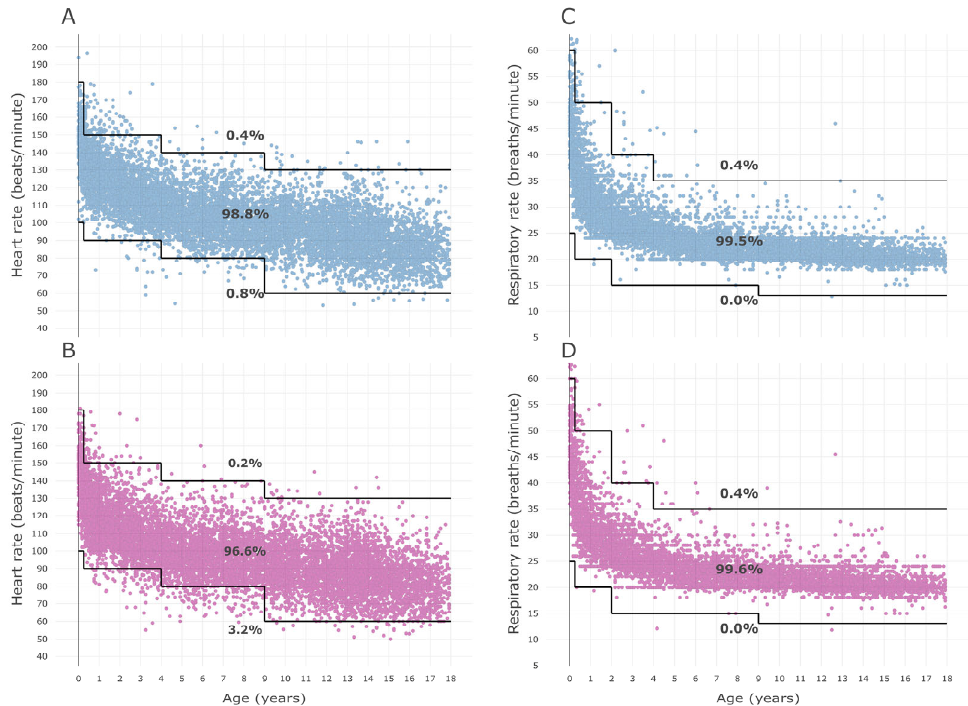
Figure 3. Distribution of HR and RR by time period and RRS activation criteria by age. (A) HR distribution during daytime, (B) nighttime HR, (C) daytime RR, and (D) nighttime RR distribution. Blue dots indicate daytime (from 8:00 to 20:00) measurements, and red dots indicate nighttime (from 20:00 to 8:00 the next day) measurements. The solid black line represents the age-specific criteria for RRS activation [12], and the percentages represent the percentages of the measured values in each range. HR = heart rate, RR = respiratory rate, RRS = rapid response